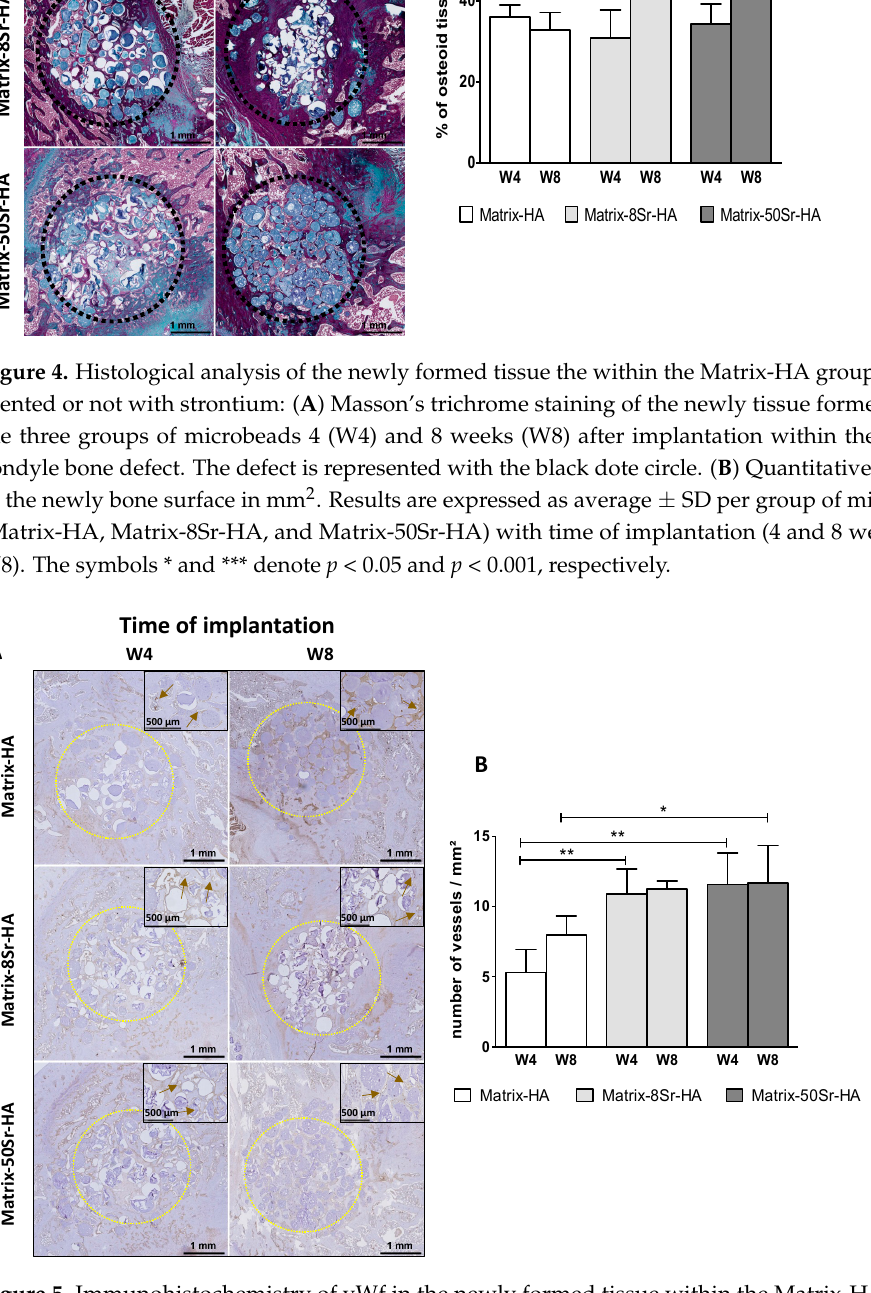
Figure 5. Immunohistochemistry of vWf in the newly formed tissue within the Matrix-HA groups supplemented or not with strontium: ( A ) vWF immunostaining of the newly formed tissue within the three groups of microbeads 4 (W4) and 8 weeks (W8) after implantation within the femoral